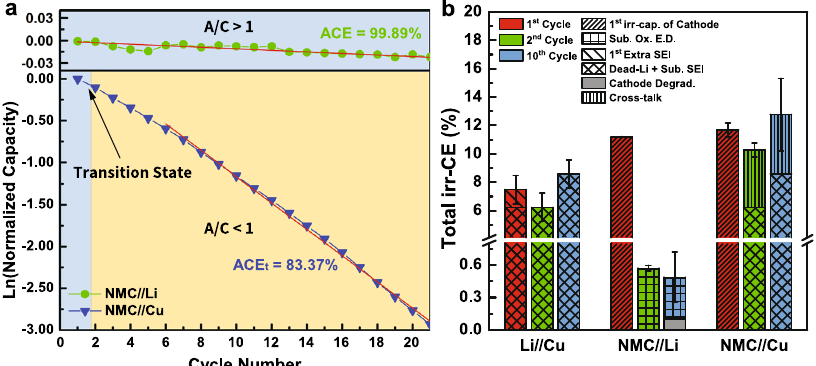
Fig. 5 Results obtained from integrated protocol using 1 M LiPF 6 in EC:DEC (1:1) as electrolyte under the current density of 0.4 mA cm − 2 . a Normalized discharge capacity versus cycle number of NMC/Li and NMC/Cu cells. b irreversible CE comparison of Li/Cu, NMC/Li, and NMC/Cu cells. Error bars represent standard deviation, n = 3 independent replicates. The capacity retention comparison of NMC/Li and NMC/Cu cells are shown in Supplementary Fig. 8b. The charge/discharge pro fi les of each cell con fi guration are shown in Supplementary Fig. 12.